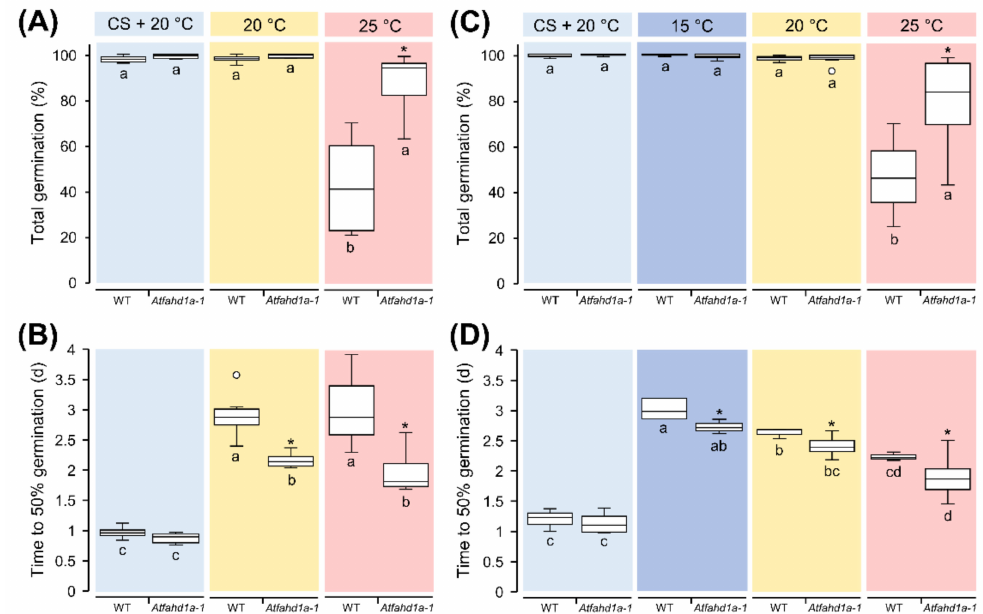
Figure 2. Germination phenotypes of wild type seeds [WT, ecotype Columbia-0 (Col-0)] and Atfahd1a-1 (fumarylacetoacetate hydrolase domain-containing protein 1a) T-DNA insertional mutant seeds in the Col-0 background. To reveal differences in thermo-dormancy, seeds were cold stratified (CS) prior to germination at 20 ◦ C and directly germinated at the indicated temperatures. ( A , B ) Total germination (TG) and time to 50% germination (T50) of WT and Atfahd1a-1 seeds produced from the first plant generation. ( C , D ) TG and T50 of WT and Atfahd1a-1 seeds produced from the second plant generation. Data are shown as box-plots (at 25 ◦ C, n = 10 and 13 replicates of 100 seeds for WT and Atfahd1a-1 lines, respectively; for all other conditions, n = 6 replicates of 100 seeds of both lines) and outliers as white circles. Within each panel, data labelled with the same letter do not differ significantly (one-way ANOVA followed by post-hoc Tukey’s HSD test, α = 0.05) and asterisks denote significant differences between WT and Atfahd1a-1 seeds germinated at the same temperature ( t -tests, p <